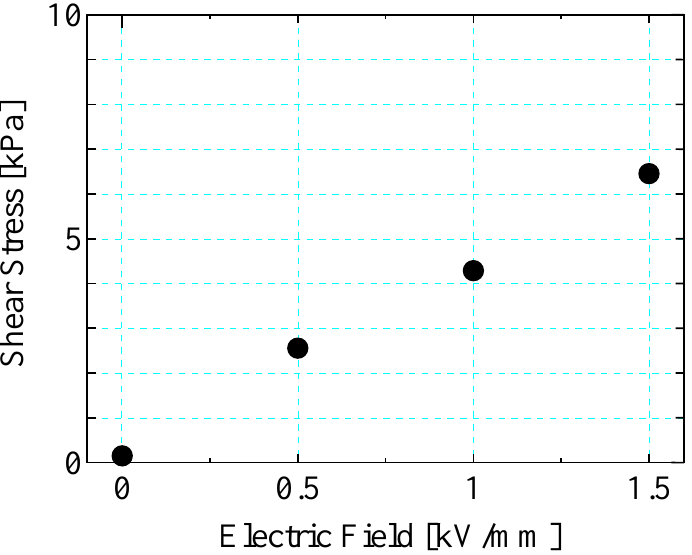
Figure 16. Shear stress of a winding EA gel sliding alongside.